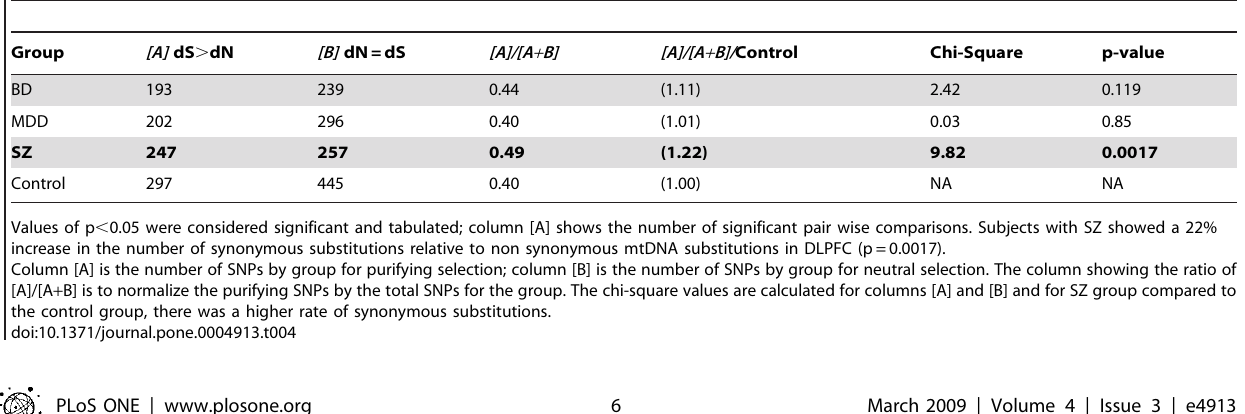
Table 4. Codon-based test of purifying selection for pair wise analysis between sequences.